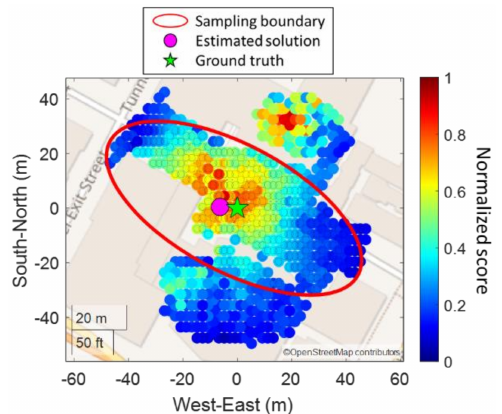
Figure 4. Example of skymask context − based candidates